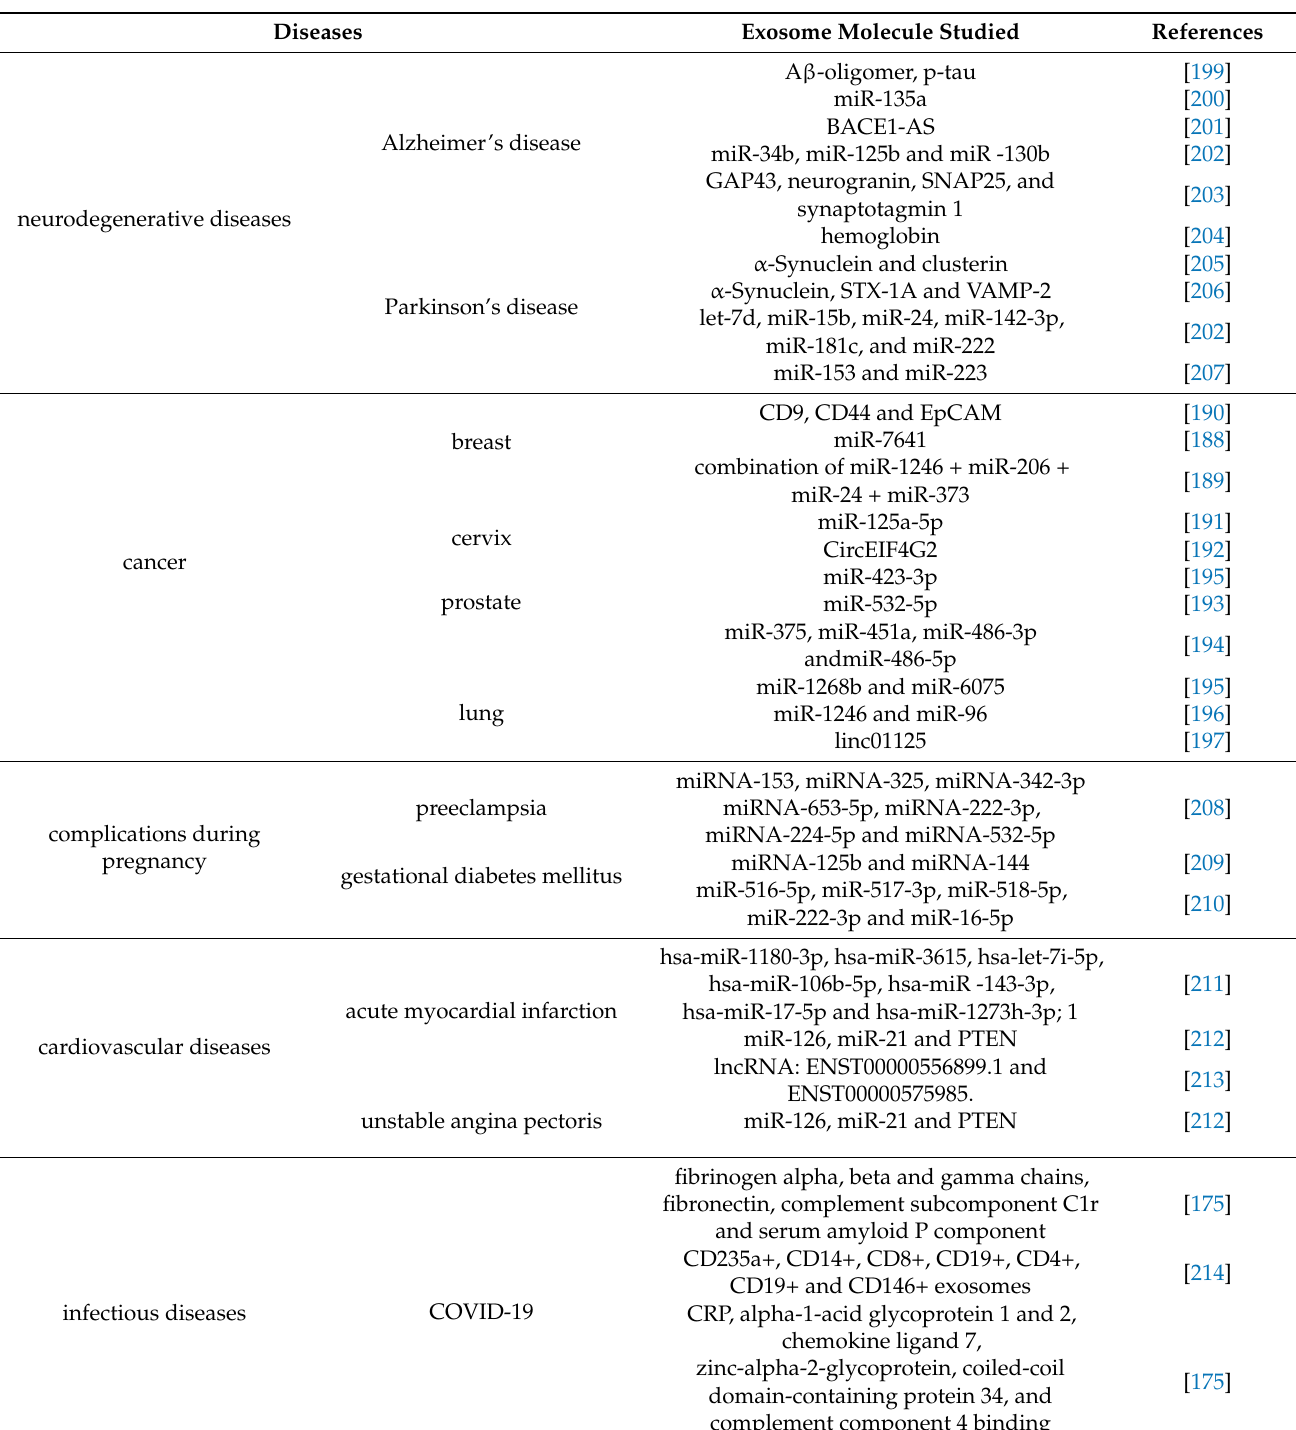
Table 2. Recent studies describing the potential role of exosomes as biomarkers for various